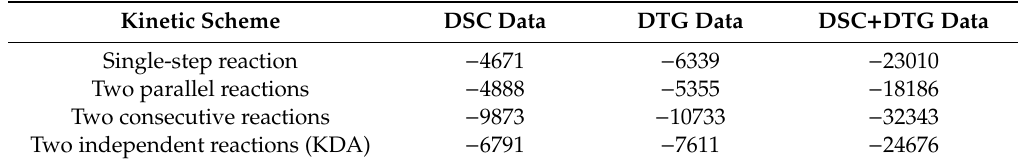
Table 2. Bayes information criteria for the formal kinetic analysis of Case 1 data with several reaction schemes.